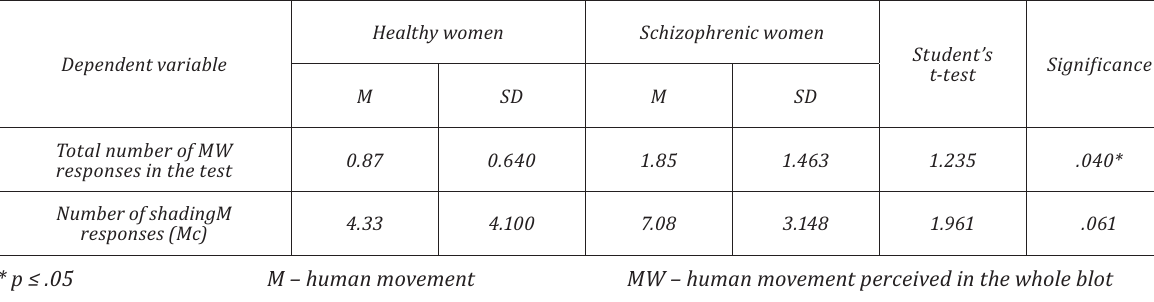
Table 2. Comparison of the groups of healthy and schizophrenic women in terms of selected movement